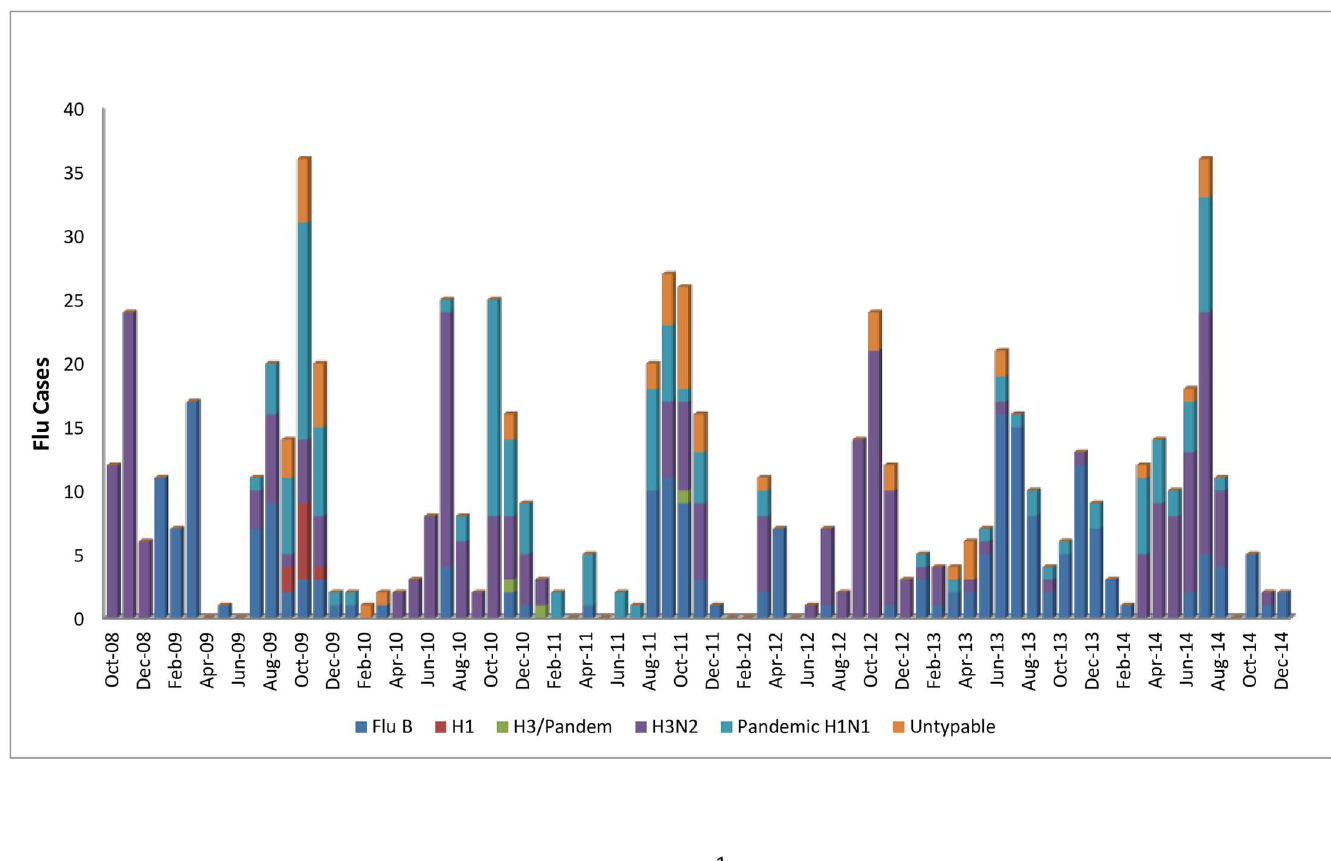
Fig 2. Temporal distribution of influenza type and subtype by